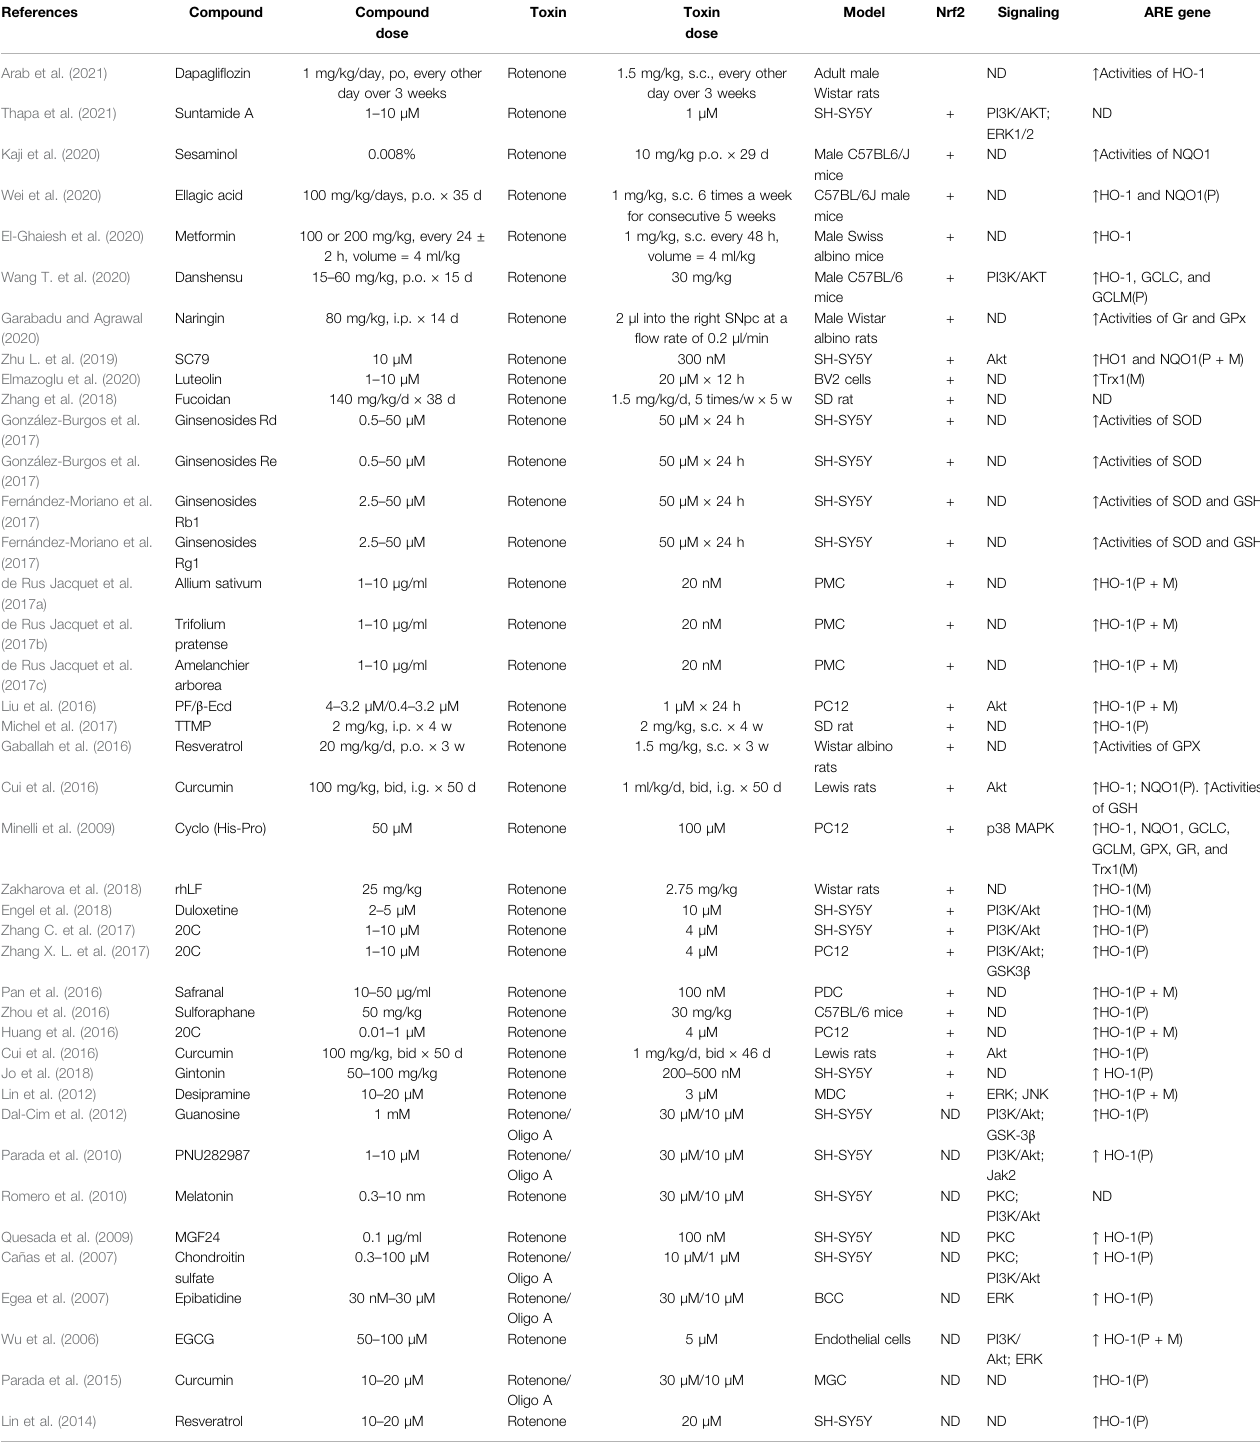
TABLE 6 | Summary of the experimental studies involving compounds able to modulate Nrf2 pathway in Rotenone-induced PD